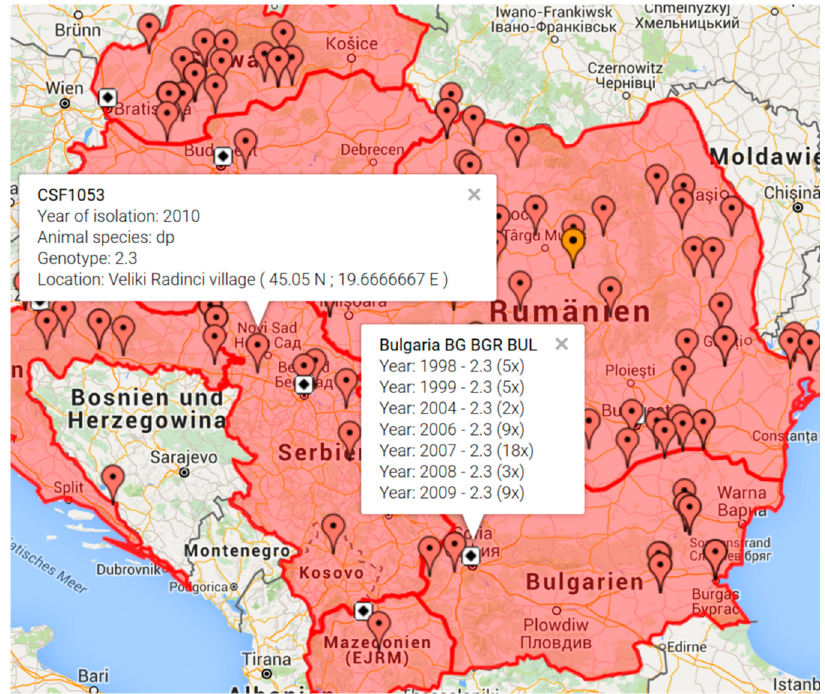
Figure 1. Geographic display of classical swine fever virus (CSFV) isolates available from the Balkan region. Map generated by the “CSF Maps” tool based on Google maps. The map was generated by selecting the countries Albania, Bulgaria, Croatia, Hungary, Macedonia, Montenegro, Romania, Serbia, and Slovakia. The options “show outbreaks”, “no display of isolates with unspecified location”, and “isolation years 1998–2010” were selected. Clicking on the flagged outbreak location provides additional information comprising catalogue number (e.g., CSF1053), year of isolation, animal species (domestic pig (dp) or wildboar (wb)), genotype, and location with longitude and latitude coordinates. Clicking on the capital of a country (symbolized by a white square with black diamond) provides an overview of available isolates from the respective country (e.g., Bulgaria) comprising isolation year, genotype, and number of available database entries.